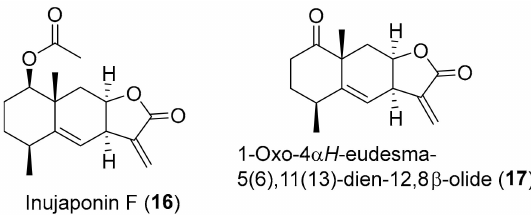
Figure 3. Chemical structure of Inula secondary metabolites ( 16 and 17 ) with reported activity against neurological oxidative-stress